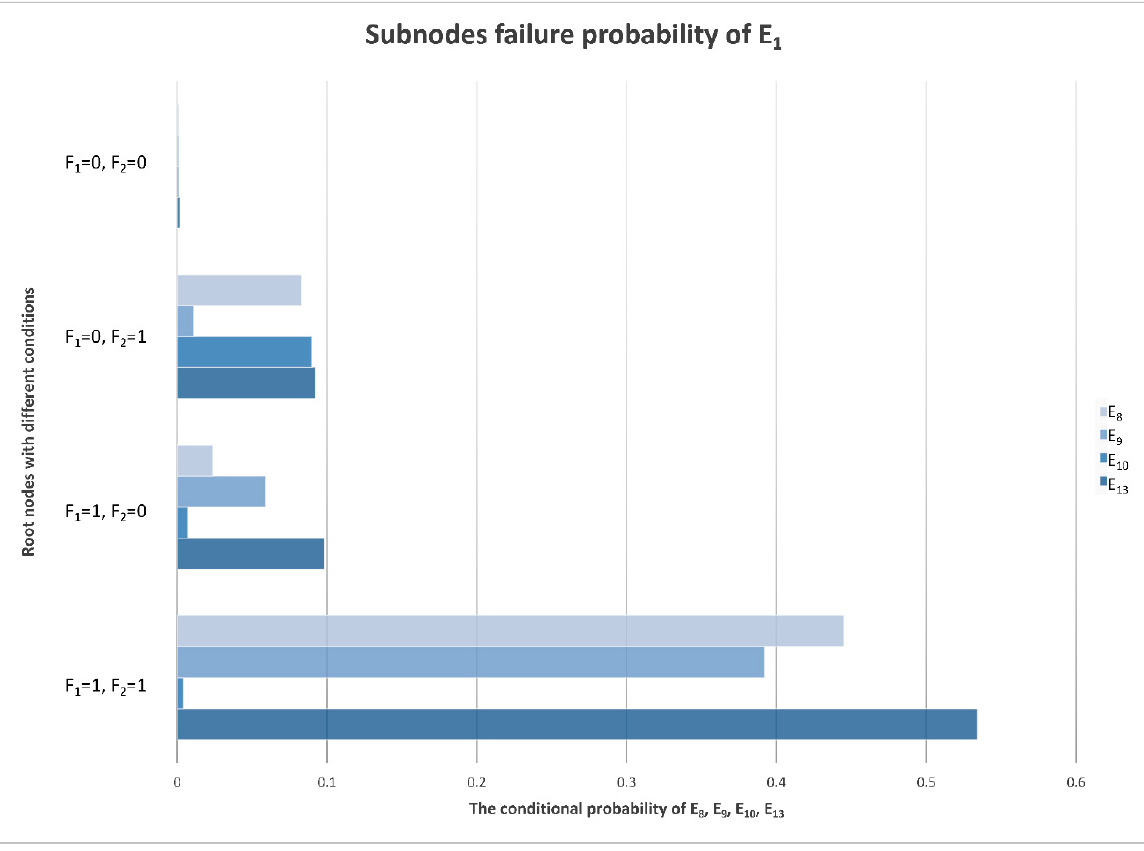
Figure 13. Conditional probability distribution diagram of E 1 ’s sub-nodes.